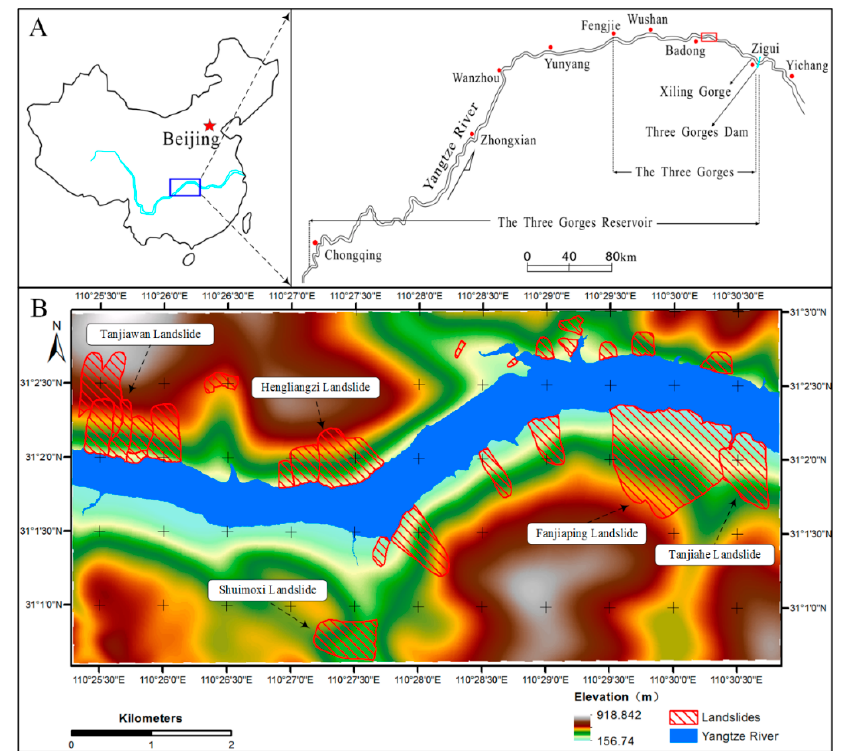
Figure 1. Location of the study area. ( A ) Site map of the Three Gorges area of the Yangtze River, China. ( B ) Digital elevation model (DEM) overlaid with landslides; the red hatched areas represent landslides areas.